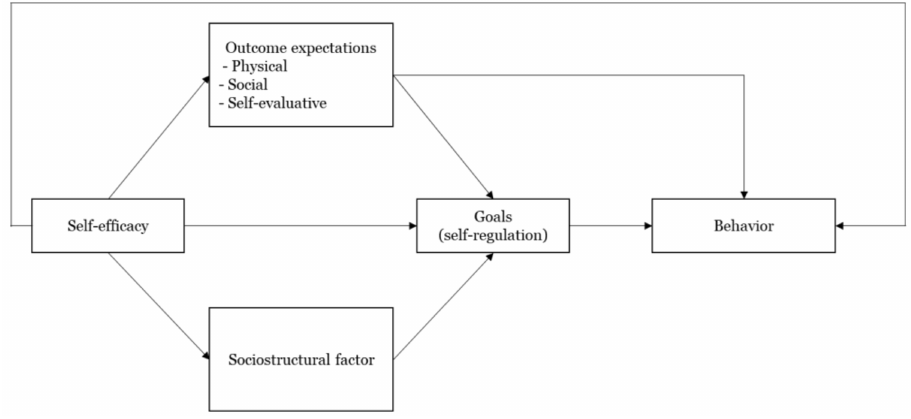
Figure 1. SCT of health behavior